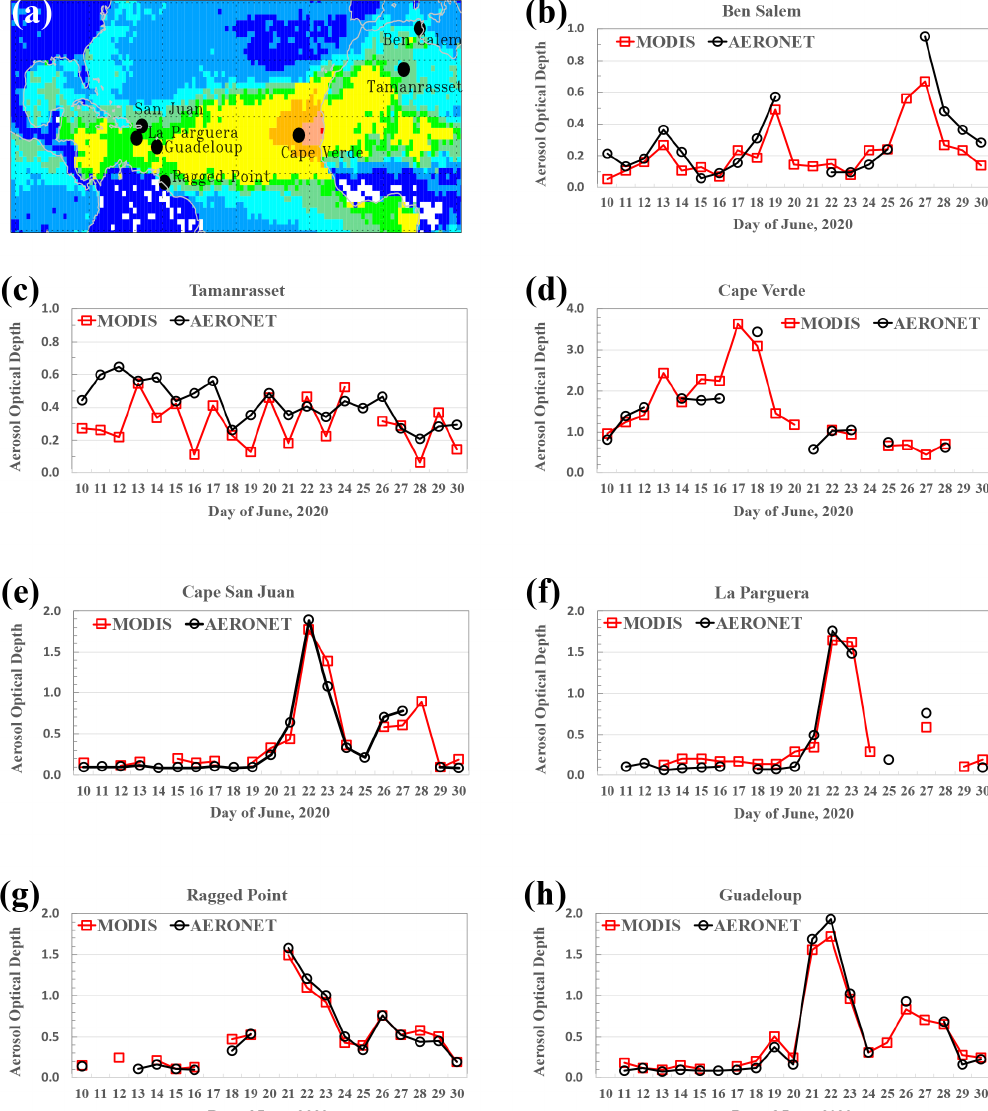
Figure 4. Time series (10 to 30 June 2020) of MODIS and AERONET daily AOD at 550nm at seven AERONET sites, as illustrated in (a) over MODIS AOD map, including (b) Ben Salem, (c) Tamanrasset, (d) Cape Verde, (e) Cape San Juan, (f) La Parguera, (g) Ragged Point, and (h)